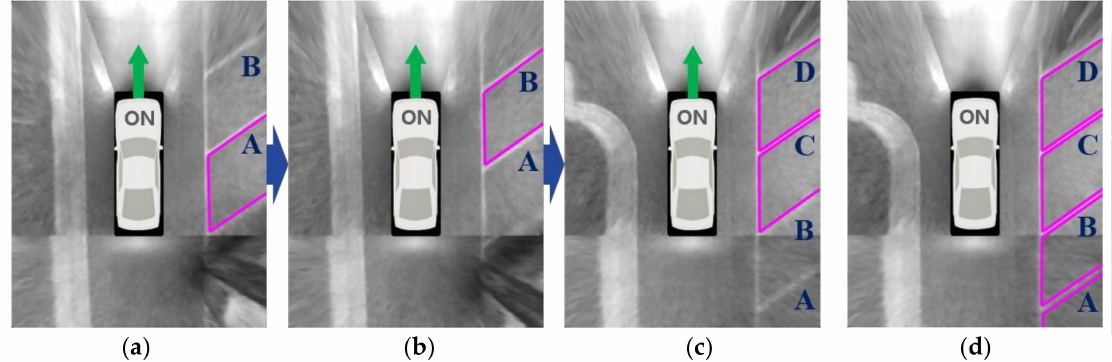
Figure 11. Parking slot tracking and combining procedure. ( a – c ) show the parking slot recognition results of three individual images; ( d ) shows the combined result of ( a – c ) using the suggested